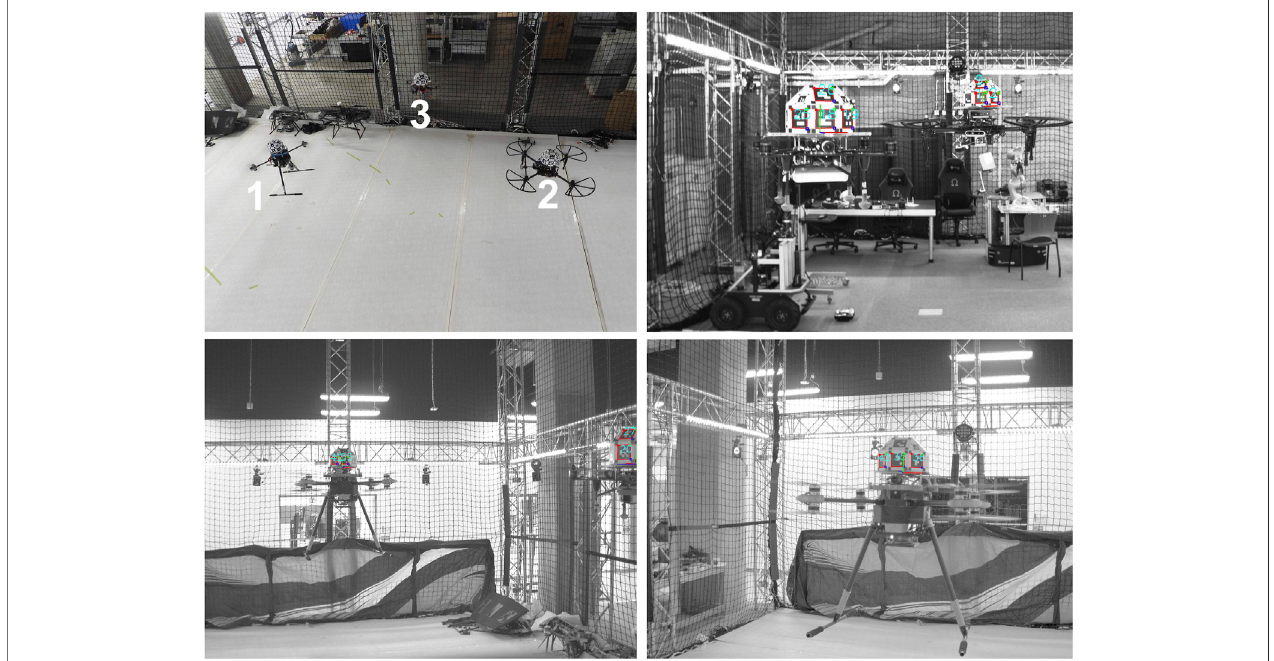
FIGURE 15 | Swarm fl ying formation and detection view per